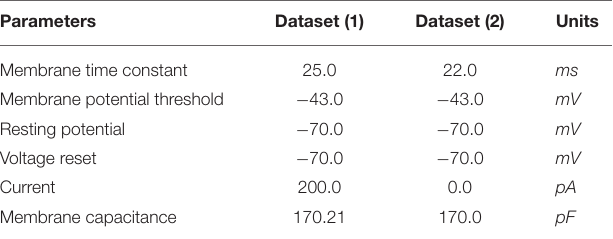
TABLE 1 | Parameter set for LIF